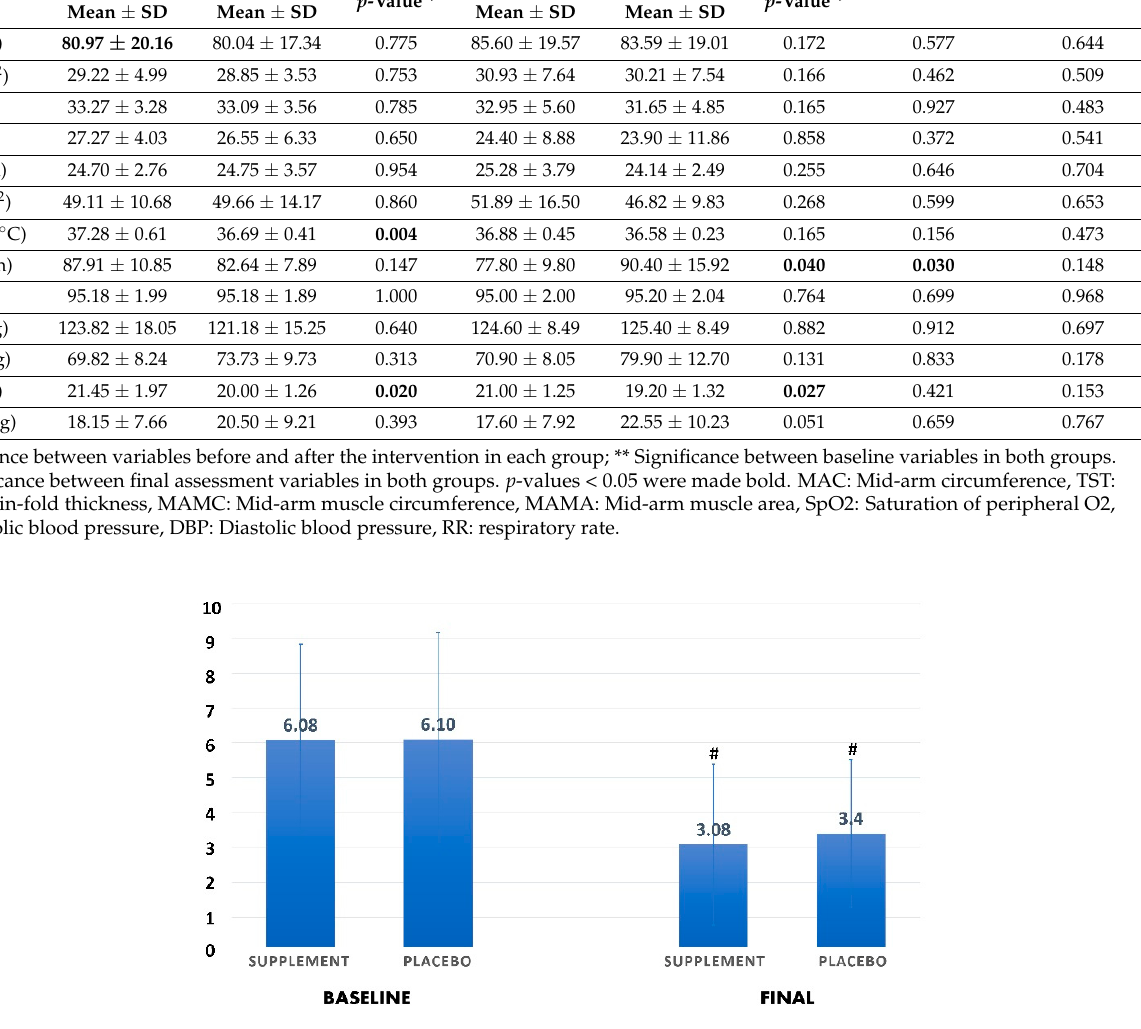
Figure 2. Changes in the clinical severity, based on PRIEST-COVID-19 clinical severity scoring system, before and after interventions in both groups. # indicates a significant difference compared to baseline scores in each group ( p < 0.05).